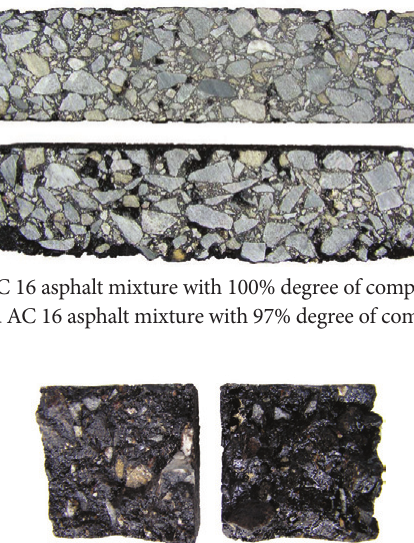
Fig. 9. Fracture surface – binder film thickness difference between mixture I AC 11 (left) and III AC 11 (right)